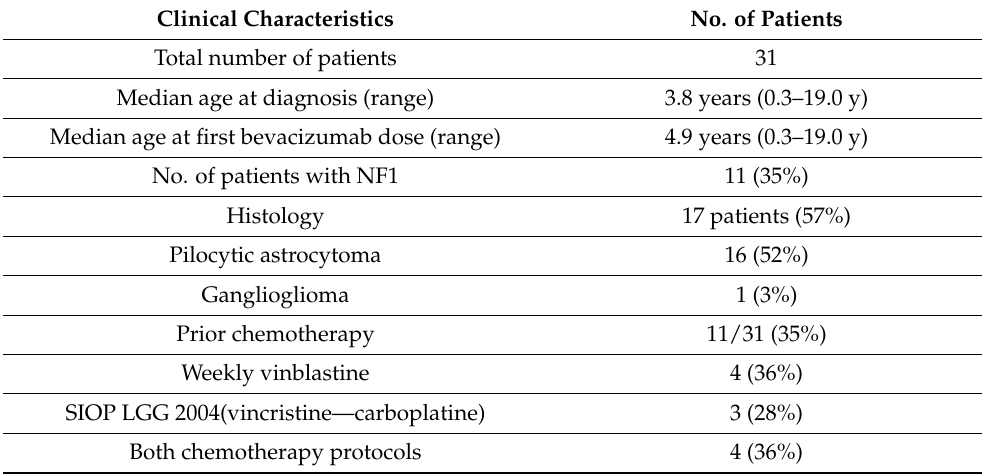
Table 1. Clinical characteristics in 31 patients treated with bevacizumab monotherapy.